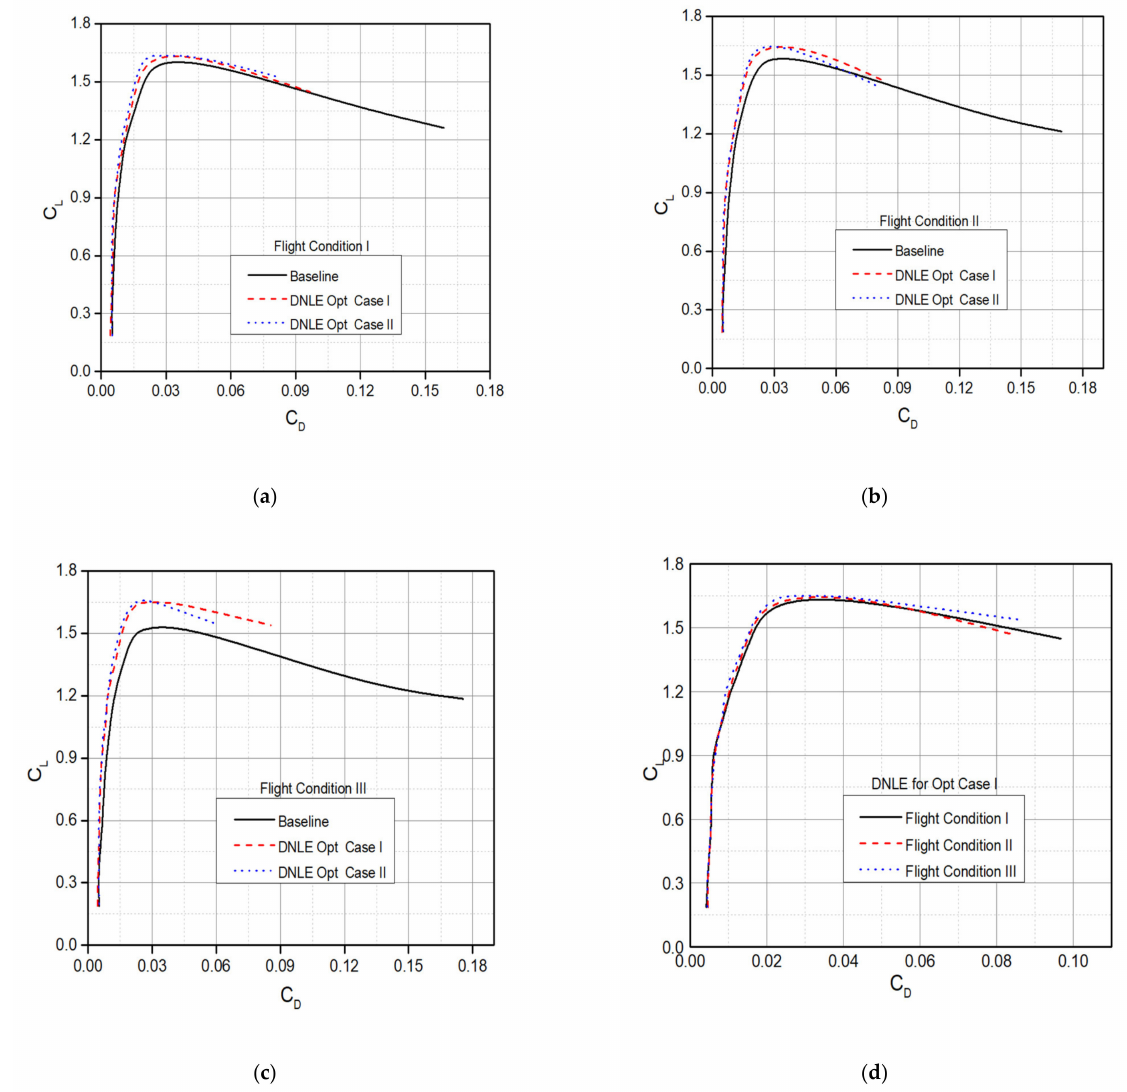
Figure 14. Aerodynamic performance for two optimized design configurations. ( a ) Figure 13a show the drag polar at Flight Condition I; ( b ) drag polar at Flight Condition II; ( c ) drag polar at Flight Condition III; ( d ) drag polar for all three flight conditions for Opt. Case I.